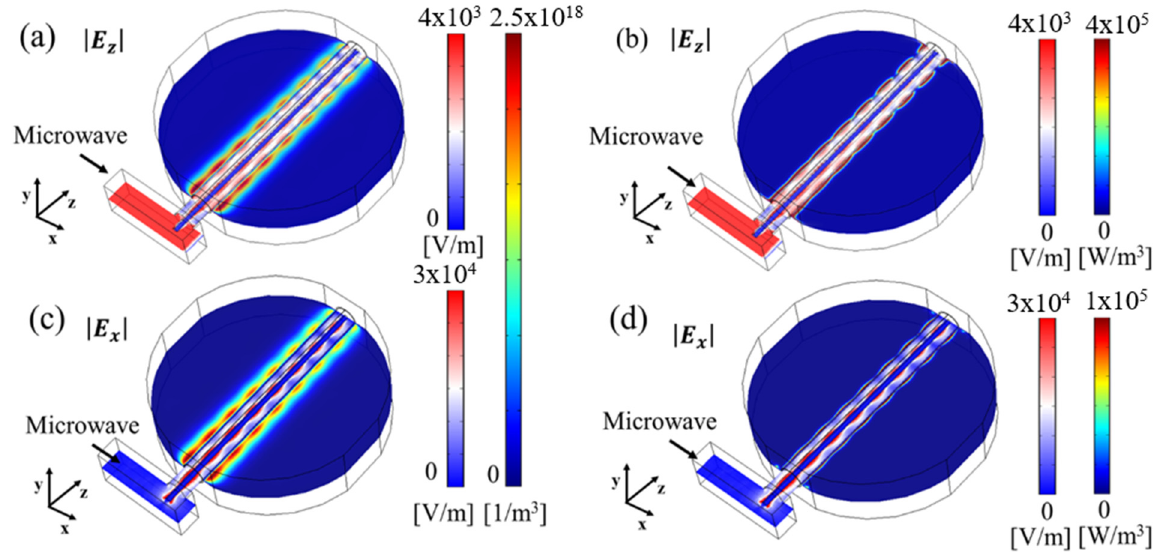
Figure 16. Electron density and power dissipation Q h , z (=Re ( 1 σ · E z · E ∗ z )) distributions according to the | E z | profile, electron 2 σ · E x · E ∗ x )) distributions according to the | E x | profile in the XZ plane of quasi density and power dissipation Q h , x (=Re ( 1 2 co-axial line TEM waveguiding structure. ( a ) Electron density distribution according to the profile of | E z | , ( b ) the distribution of power dissipation value Q h , z according to the profile of | E z | , ( c ) electron density distribution according to the profile of | E x | , and ( d ) the distribution of power dissipation value Q | E x | h , x according to the